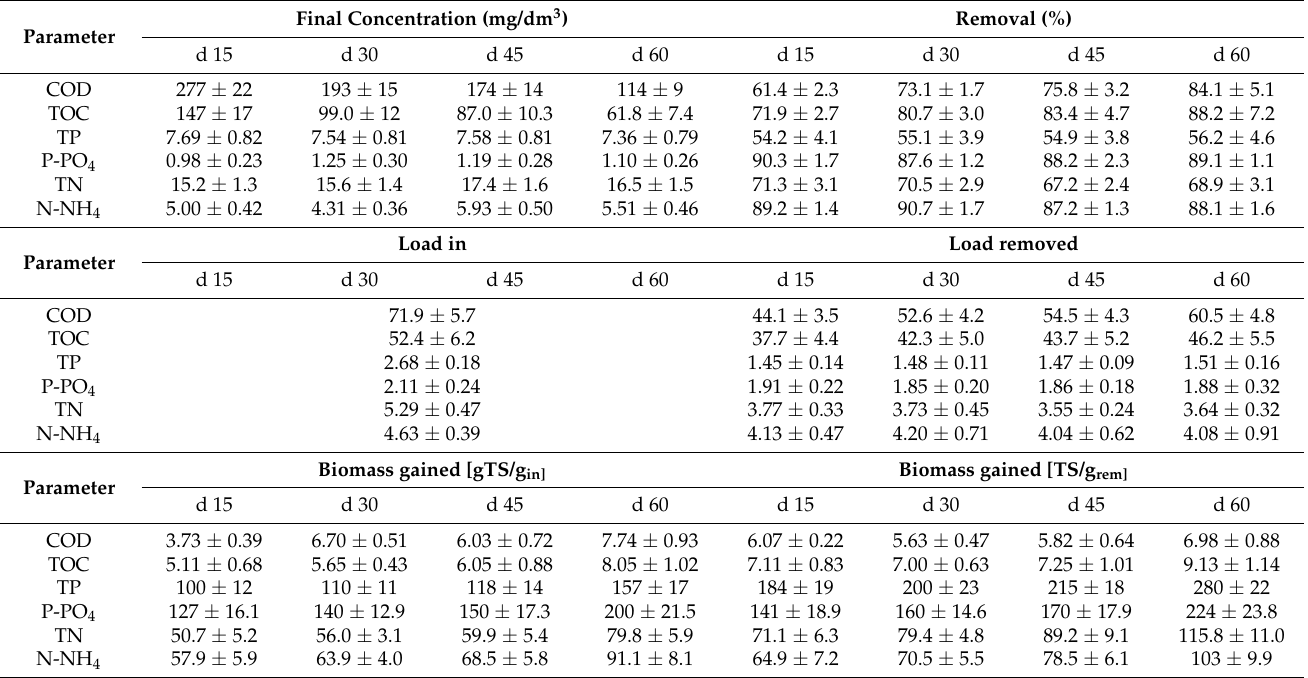
Table 5. Indicators of LF-DSS treatment